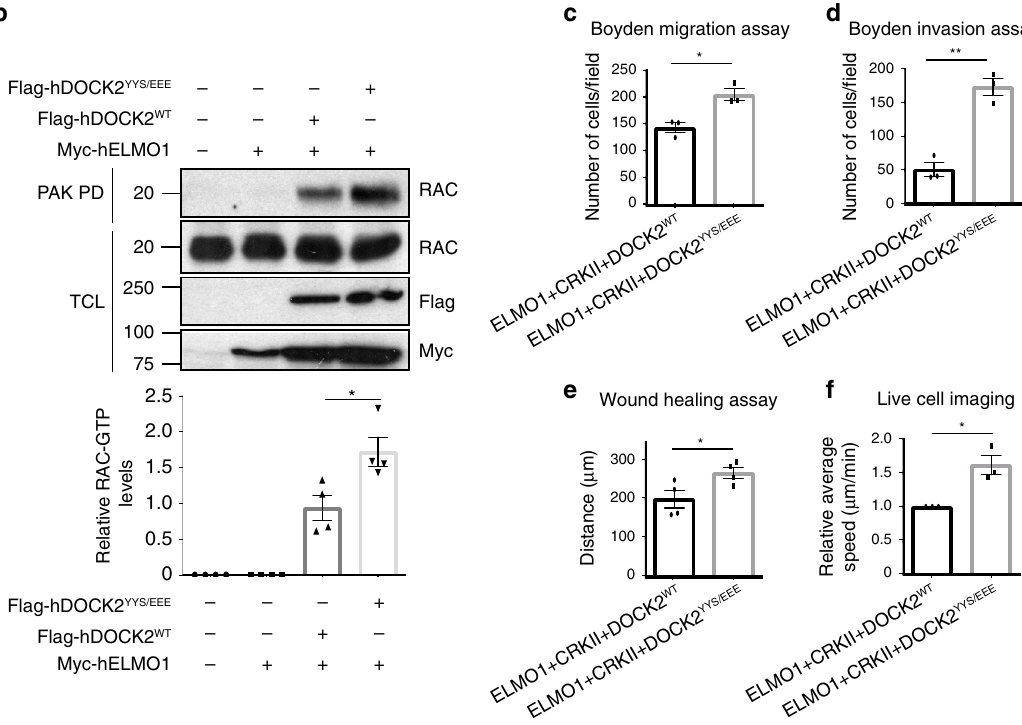
Fig. 7 Phosphorylation of DOCK2 at the ELMO NTD – DOCK2 C2 interface promotes RAC1 signalling. a DOCK2 sequence alignment. Schematic of DOCK2 domains is shown. The aligned region is indicated within dashed lines. Sites highlighted in red are conserved within the different species. White labelled amino acids were identi fi ed on PhosphositePlus with the highest references. b RAC1 activation levels are increased upon DOCK2 YYS/EEE expression. 293 T cells transfected with the indicated plasmids were subjected to a RAC activation assay (GST-PAK1 PBD pulldown). RAC activation levels were detected by western blotting and quanti fi ed using ImageJ. Three biologically independent experiments were performed with similar results. Boyden migration ( c ) and invasion ( d ) assay performed with HeLa cells transfected with the indicated plasmids. Number of cells migrated were counted by DAPI staining of the membrane (the experiments were performed three times, imaging 10 fi elds using a 10X objective per condition). e Quanti fi cations of transfected HeLa cells displacement in a wound healing assay. The experiments were performed four times, imaging four fi elds using a 10X objective per condition. f Average speed of transfected HeLa cells time-lapse imaged for 6 h. Average speed was quanti fi ed using manual tracking on ImageJ. The experiments were performed three times, imaging four fi elds used at 10X per condition per experiment. Data were analysed from three experiments and expressed as mean ± s.e.m. Two-tailed unpaired student ’ s t test was used ( c , d , e , f ) and Mann – Whitney test ( b ). (* p = 0.0286 ( b ); * p = 0.0138 ( c ); ** p = 0.0017 ( d ); * p = 0.0424 ( e ); * p = 0.0123 ( f )). Source data are provided as a Source Data fi